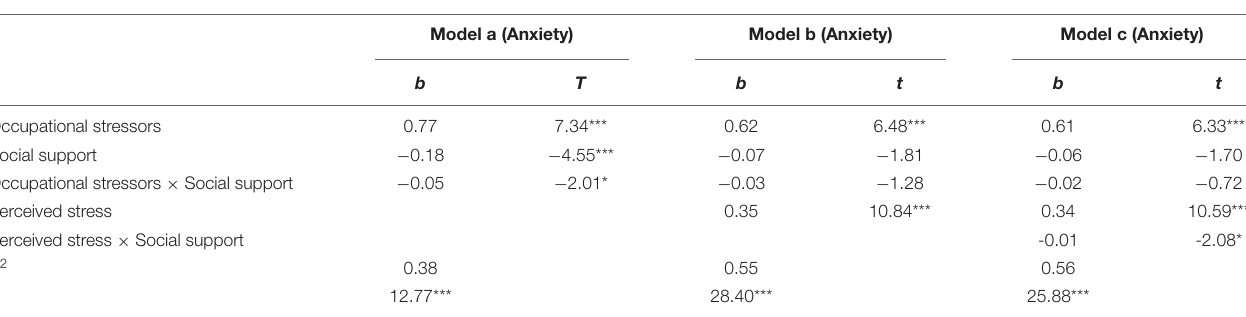
FIGURE 2 | The mediation model of perceived stress, (A) Perceived stress mediation model for anxiety, (B) Perceived stress mediation model for depression, and (C) Perceived stress mediation model for insomnia. ∗ p < 0.05; ∗∗ p < 0.01; and ∗∗∗ p < 0.001. TABLE 4 | Testing the moderated mediation effect in the model of